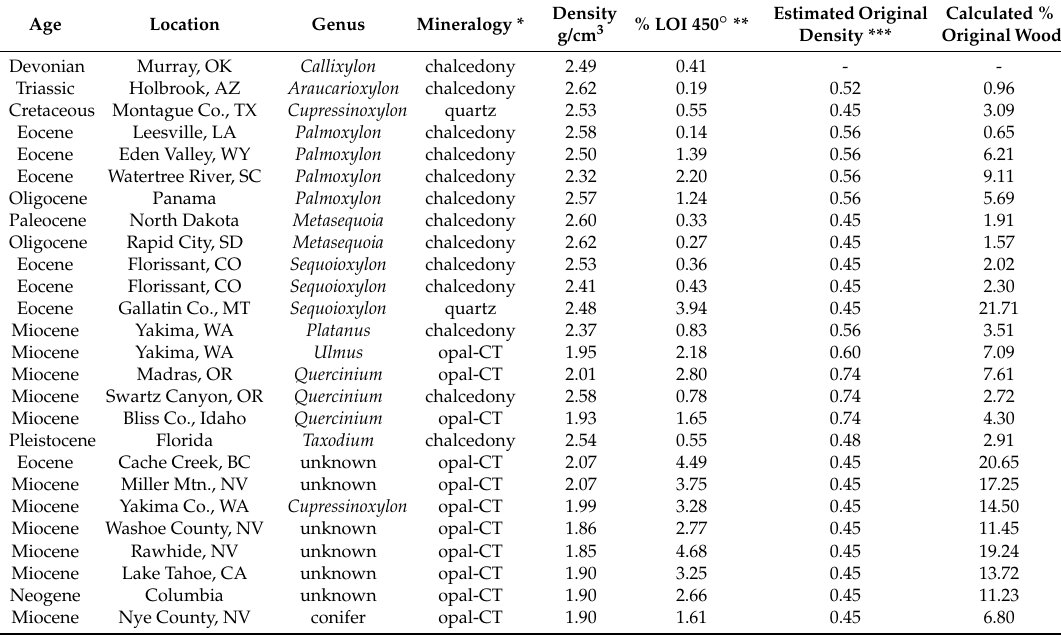
Table 1. Preservation of relict organic matter in silicified